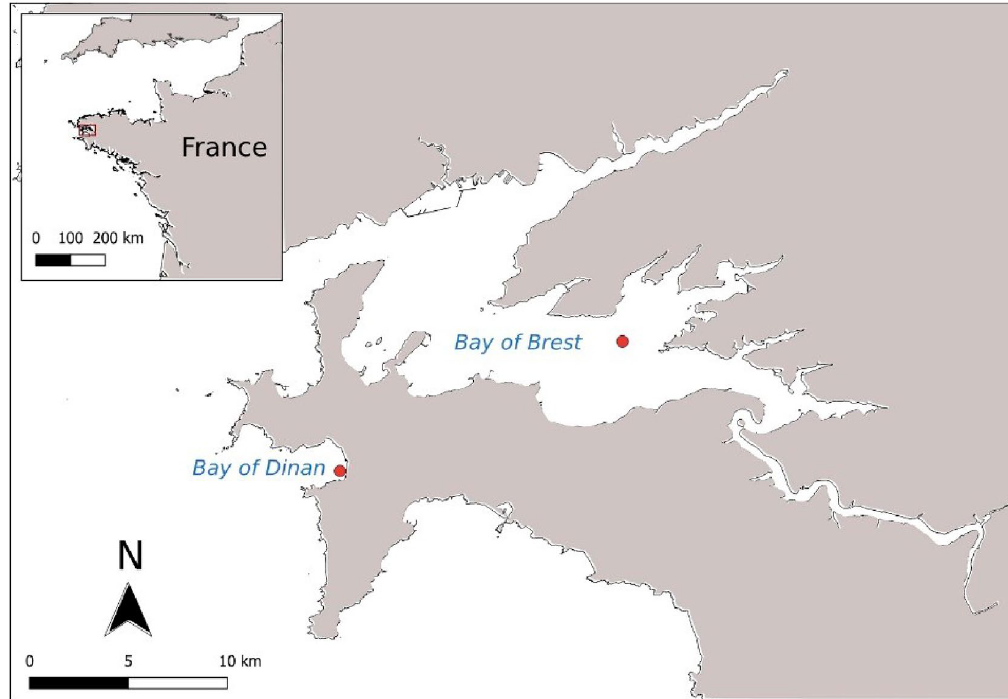
Fig. 1. – Location of the sampling sites: maerl bed (Bay of Brest) and sandy beach (Anse de Dinan) in Brittany,